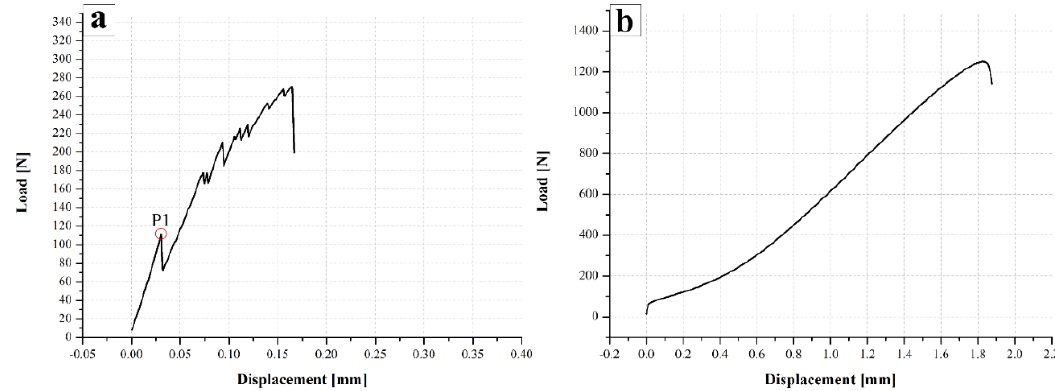
Figure 9. SPT curves of ( a ) AlCrFeNi (w / o Co) (as an example of the BCC + B2 dual phase alloy) and ( b ) CoCrFeNi (w / o Al, Face centered cubic (FCC) solid